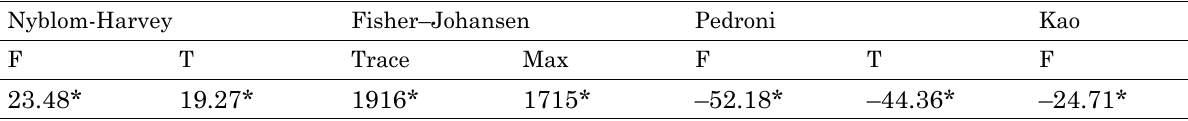
Table B3. Panel cointegration tests